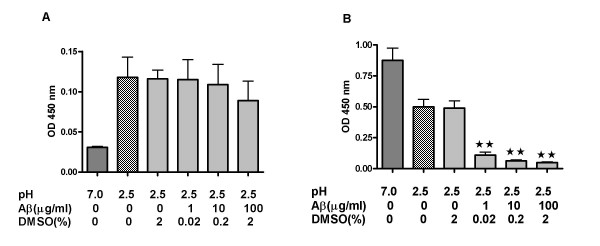
Incubation at pH 2.5 induced artifactual ELISA signal has a lower affinity for Aβ than authentic anti-Aβ antibodies in competition assays. Sera from unvaccinated mice (panel A) or mice vaccinated with Aβ 1–42 peptide (panel B), were diluted 1:1000 and preincubated at either pH 7 or pH 2.5. After centrifugation, neutralization and reconstitution of sera volume, the sera were then incubated with human Aβ1–42 peptide, at increasing concentrations at 37°C for 60 minutes. Because the Aβ was initially dissolved in DMSO, some samples were also incubated with 2% DMSO as control. The ELISA assay was then performed as described in methods with no further separation of Aβ and antibody fractions. ** P < 0.001 compared to pH 2.5 without Aβ preincubation.